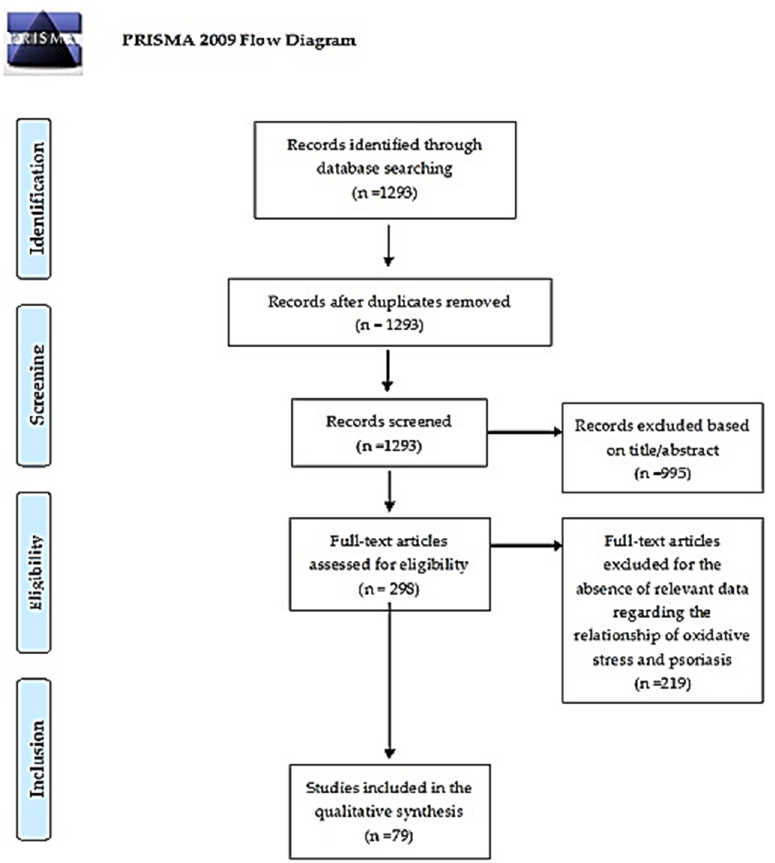
Figure 1. PRISMA 2009 Flow Diagram. From Moher, D.; Liberati, A.; Tetzlaff, J.; Altman, D.G.